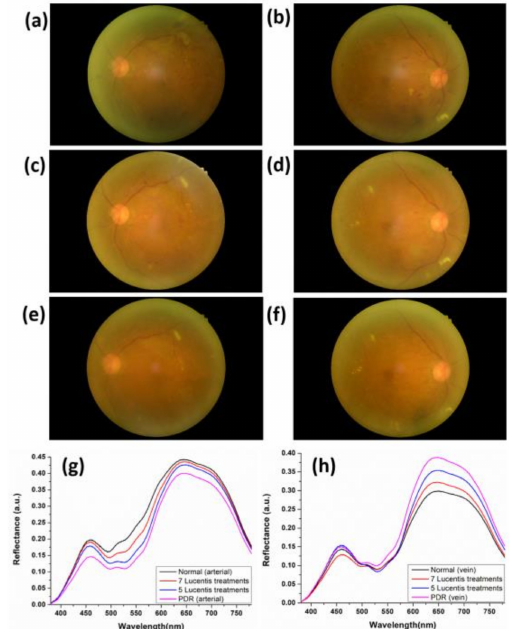
Figure 8. Ophthalmoscope image of PDR patients before and after anti-VEGF treatment: ( a ) Left eye before treatment, ( b ) right eye before treatment, ( c ) left eye after five Lucentis treatments, ( d ) right eye after five Lucentis treatments, ( e ) left eye after seven Lucentis treatments, ( f ) right eye after seven Lucentis treatments; average reflection spectrum of Normal and PDR retinas after five Lucentis and seven Lucentis treatments of ( g ) arterial and ( h )